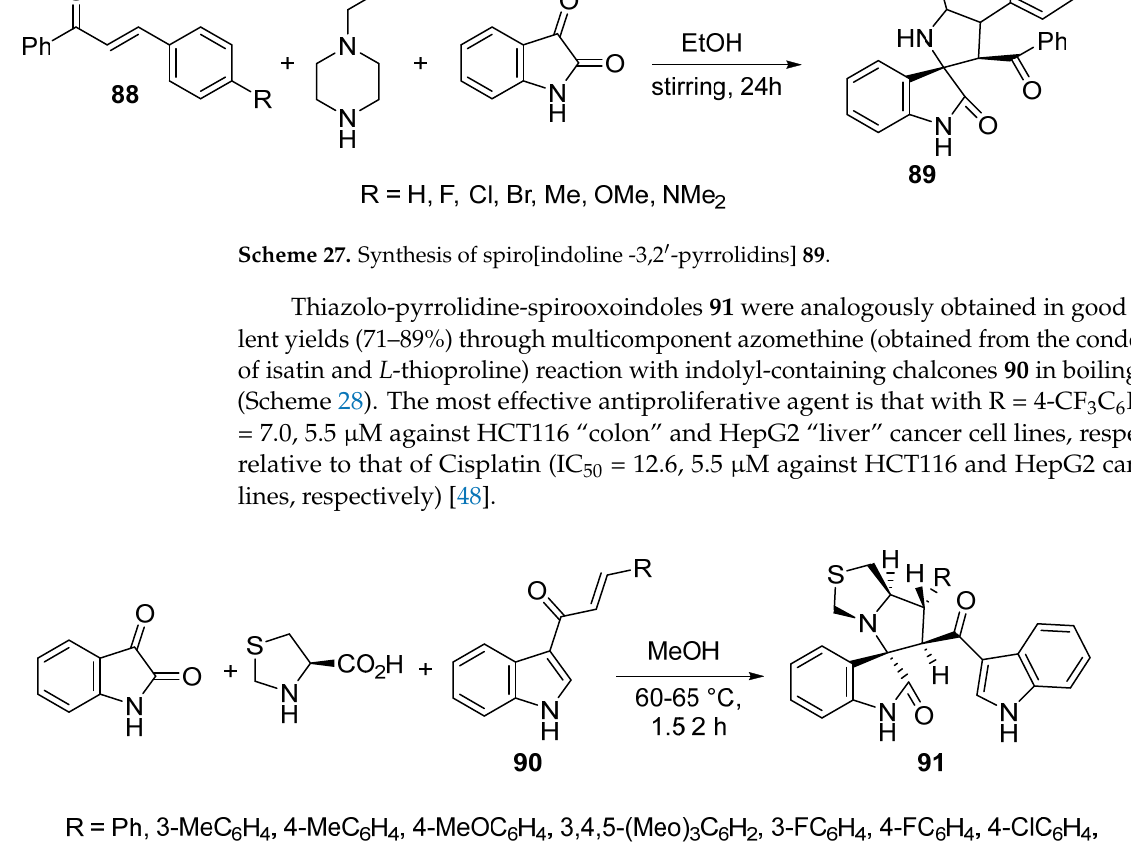
Scheme 28. Synthesis of thiazolo-pyrrolidine-spirooxoindoles 91 .